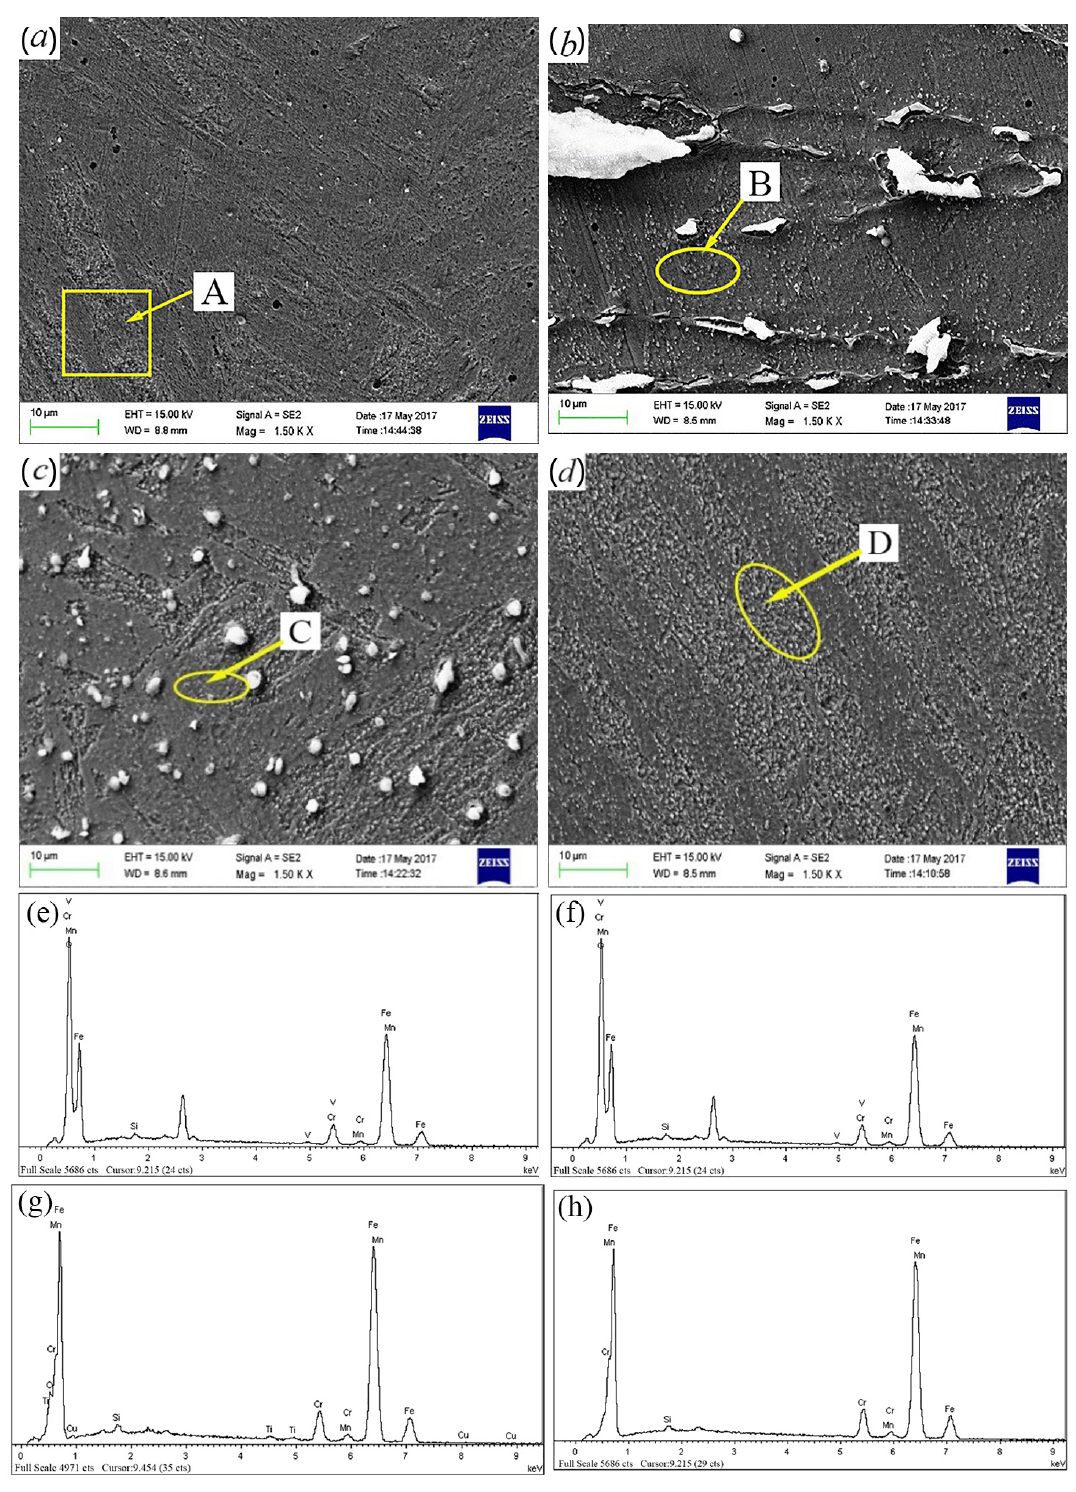
Figure 6. SEM morphology and EDS analysis in weld zone under different holding time: (a) SEM morphology of joint unannealed, (b) SEM morphology under holding 4h, (c) SEM morphology under holding 5h, (d) SEM morphology under holding 6h, (e) EDS result in A region, (f) EDS result in B region, (g) EDS result in C region, and (h) EDS result in D